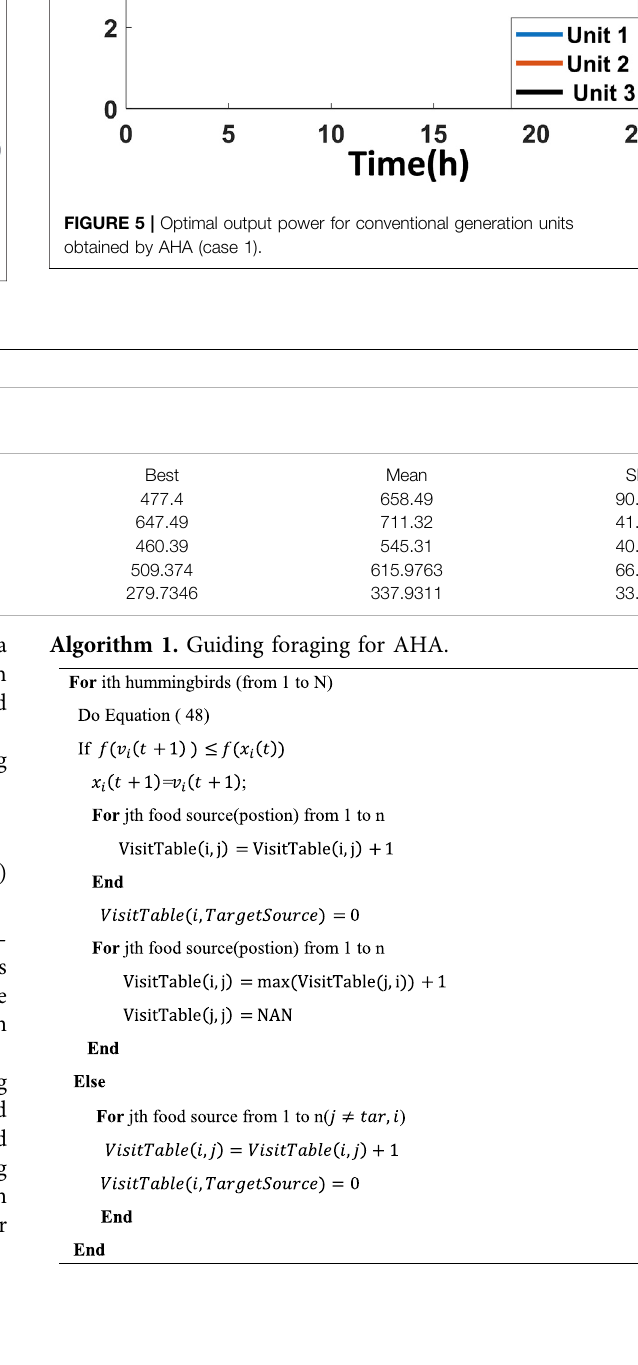
Algorithm 1 for guided foraging and in Algorithm 2 for territorial forging.